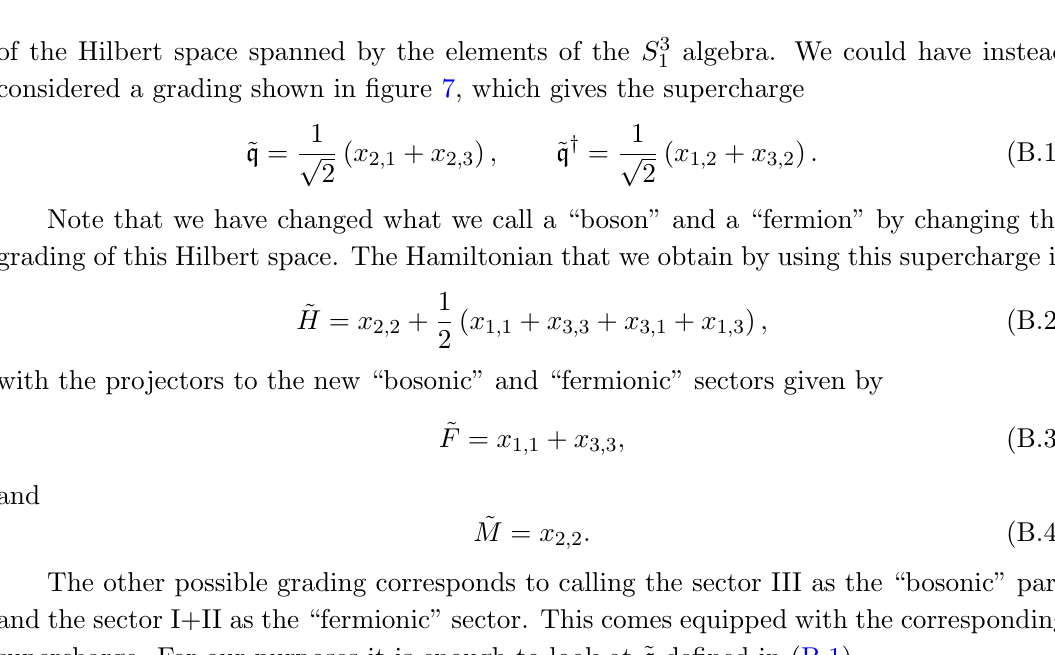
Figure 7 . Another grading of the Hilbert space spanned by S 3 the \bosonic" and \fermionic" parts